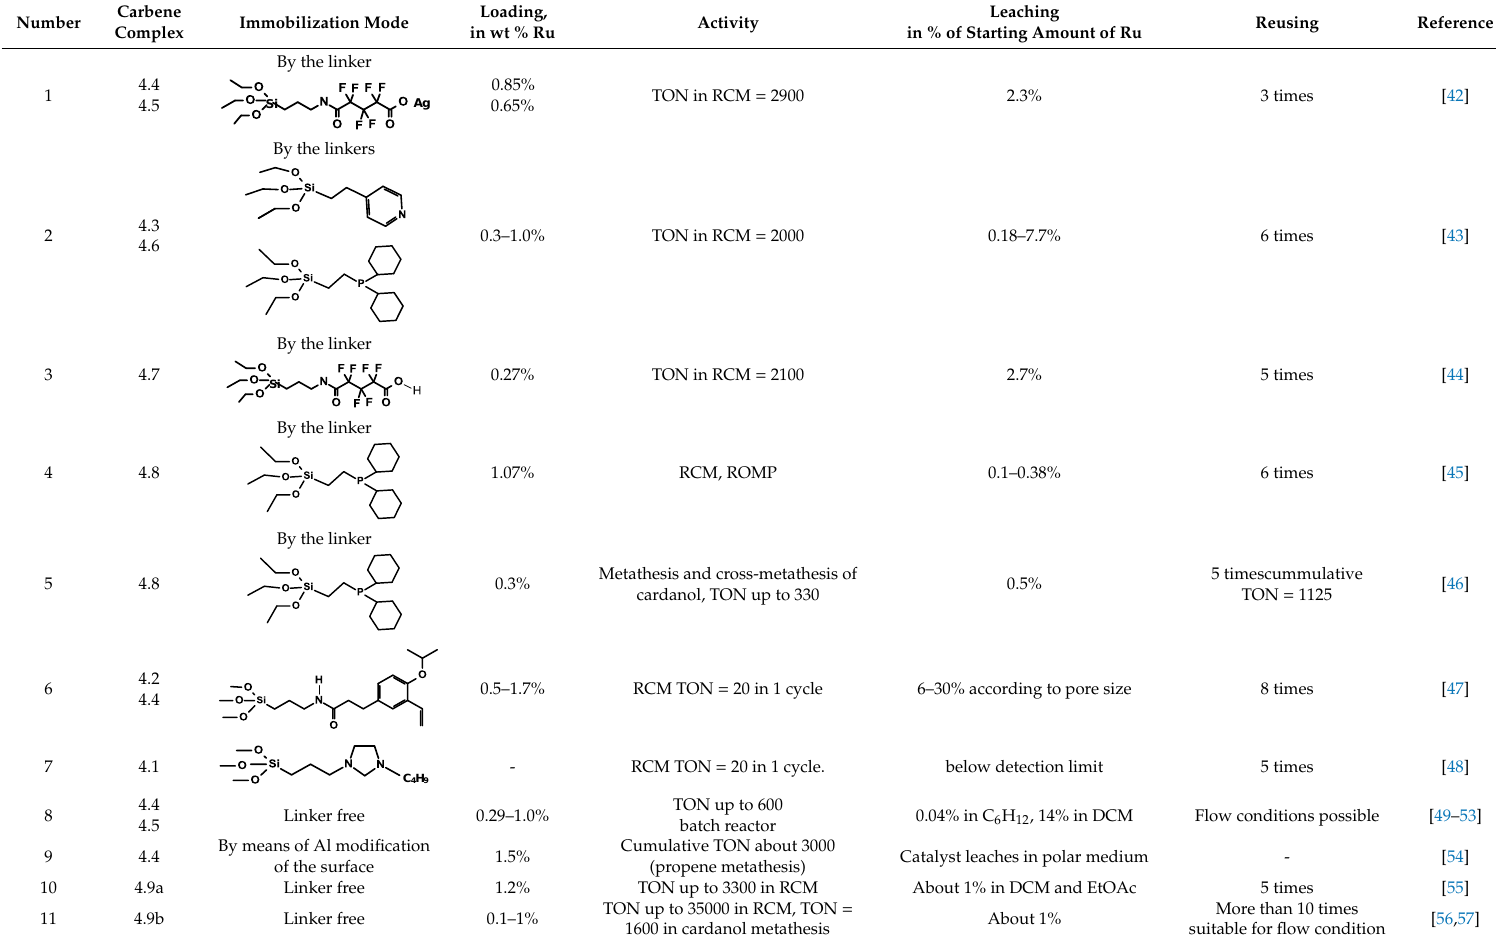
Table 1. Survey of Ru carbenes immobilized on Santa Barbara Amorphous (SBA-15)